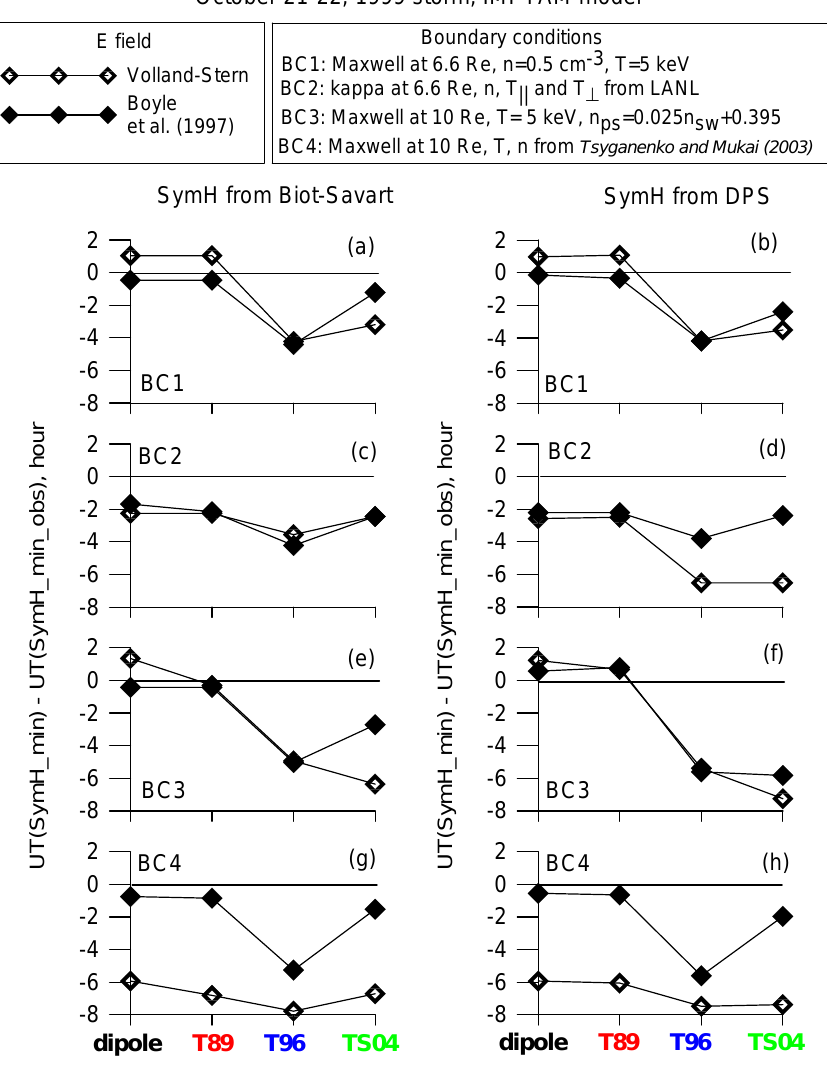
Fig. 15. UTs of the minimum SymH* values of the modeled SymH* profiles during 21–22 October 1999 storm, similar to Fig.